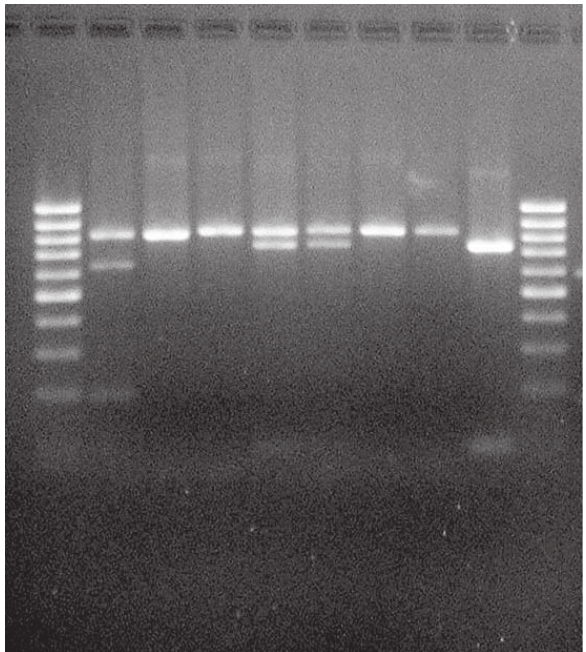
Fig. 3. ITS-RFLP patterns of I. jamaicensis using the restriction endonuclease Alu I. Lane 1 and 11, size mark- er (high-intensity: 500 and 1000 bp); lane 2, amplicon;